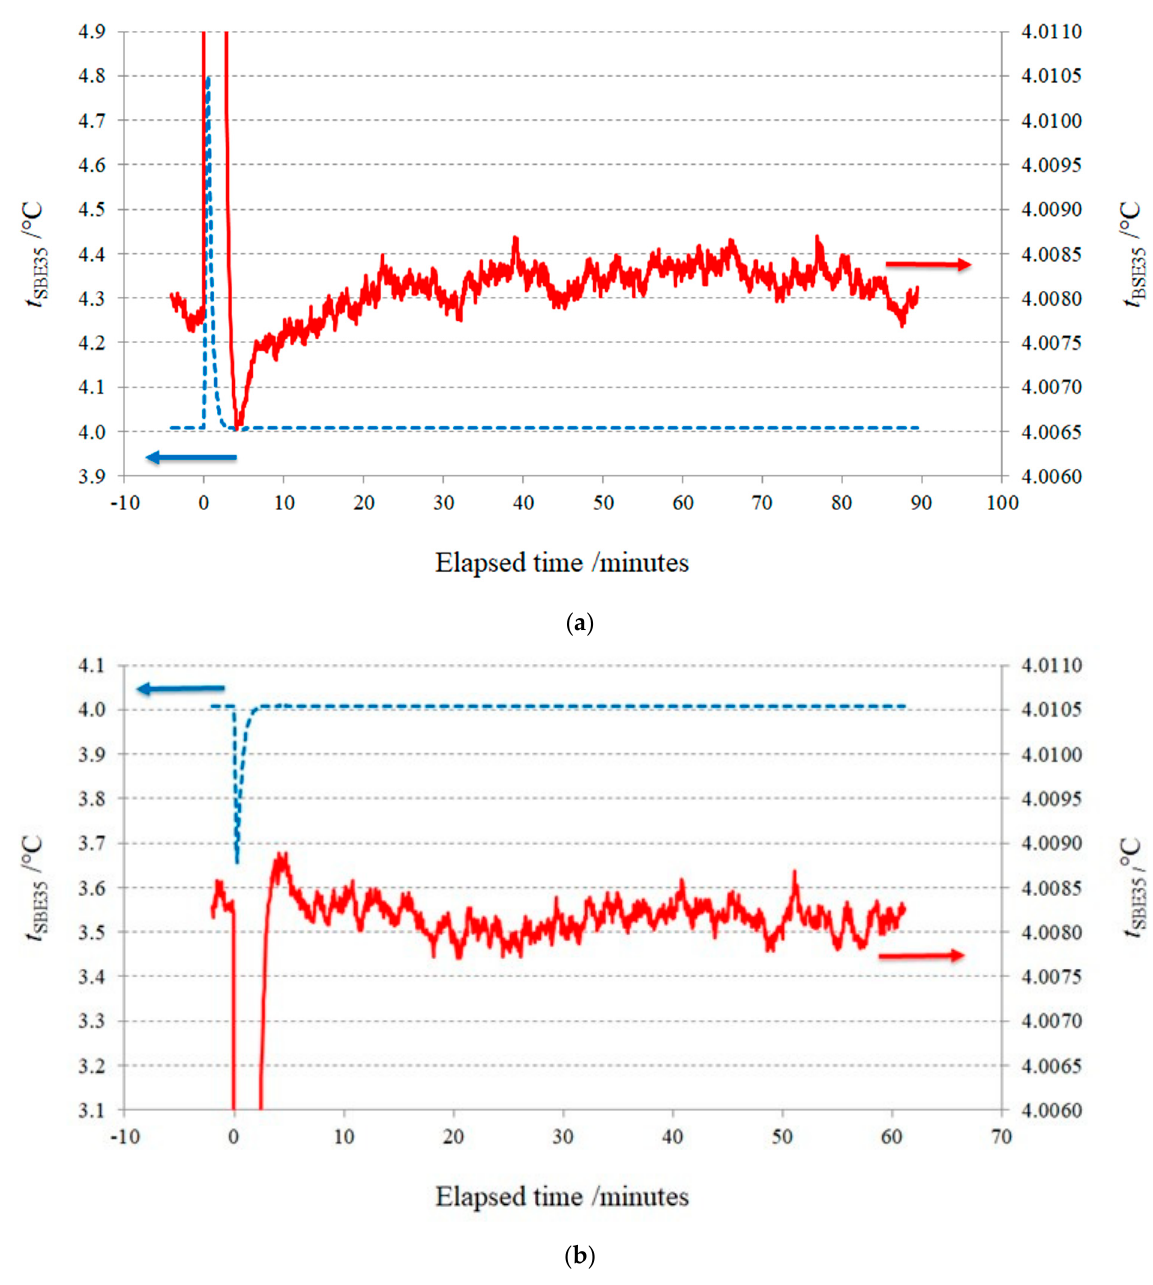
Figure 8. Time evolution of the SBE35 temperature reading ( a ) at and after pressurization from atmospheric pressure to 50 MPa and ( b ) at and after de-pressurization from 50 MPa to 30 MPa. The dotted blue line and the continuous red line corresponds to the same SBE35 temperature reading, showed on different temperature scales (left scale for the dotted blue line and right scale for the continuous red line), in order to show both the whole peak and the stabilization after the peak.